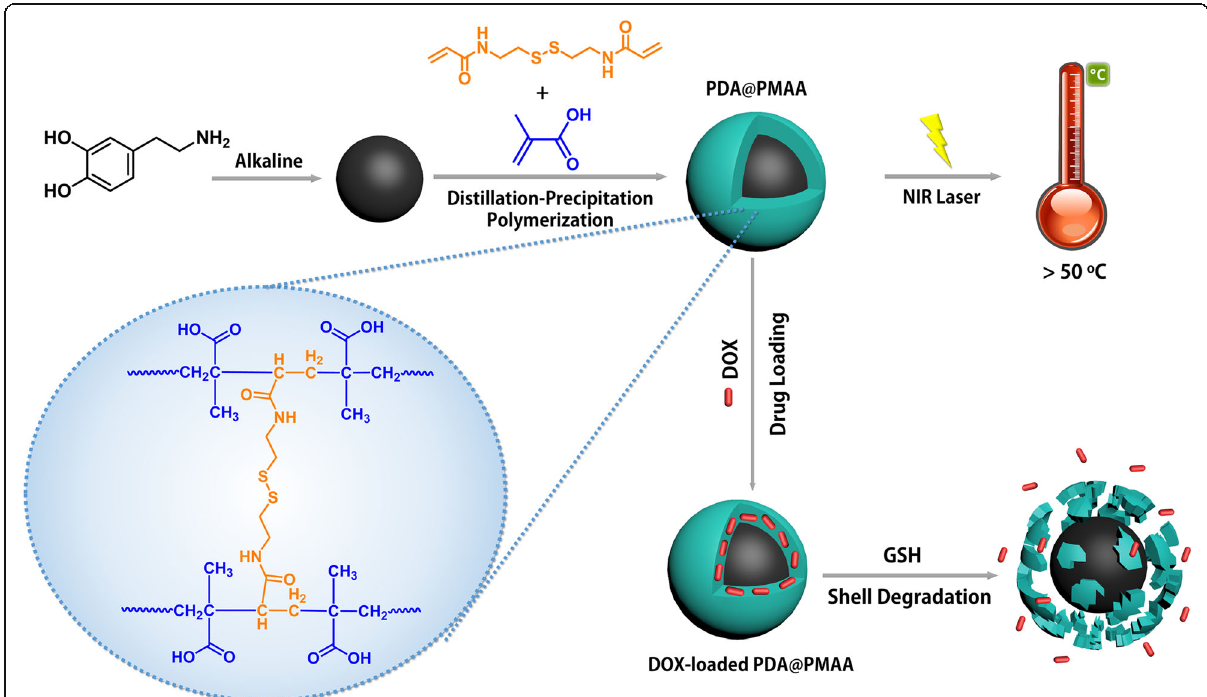
Fig. 1 Schematic illustration of the synthesis, photothermal effect, drug loading, and stimuli-responsive drug release of PDA@PMAA nanoparticles